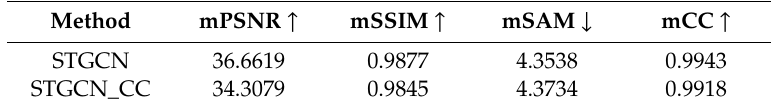
Table 4. Quantitative evaluation of cloud removal algorithms based on gated convolution layers and common convolution layers on data I. STGCN_CC indicates gated convolution layers in our STGCN have been replaced by common convolution ones.